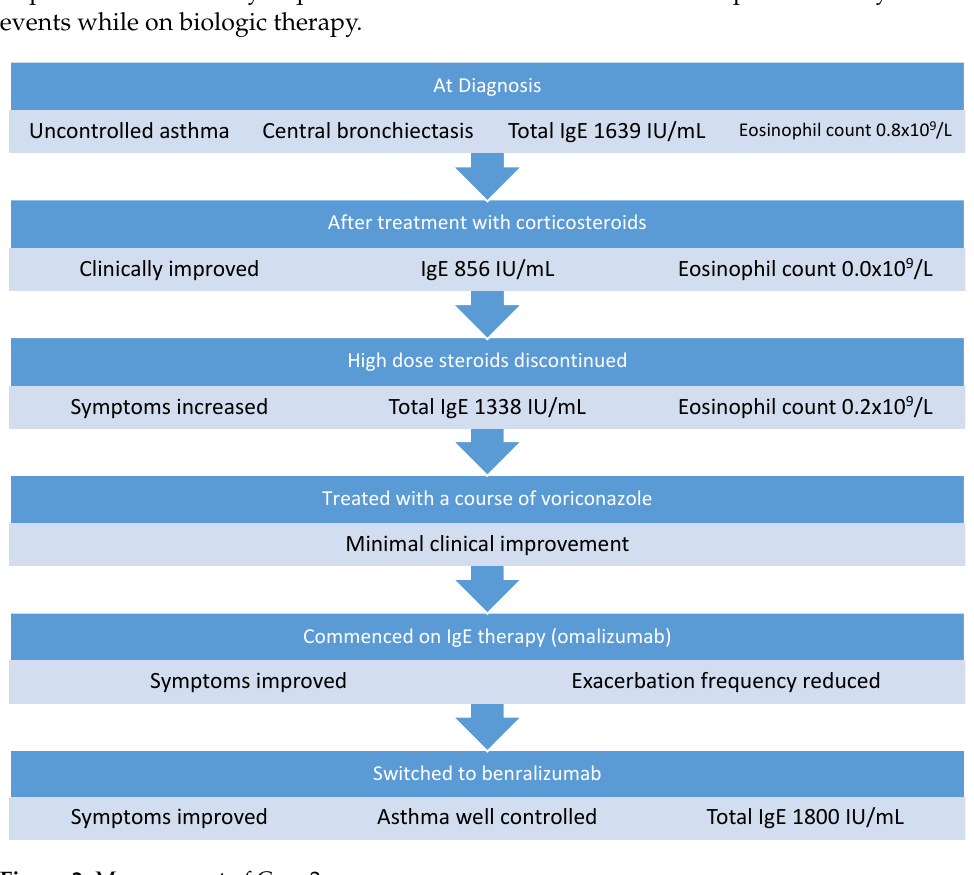
Figure 2. Management of Case 2.